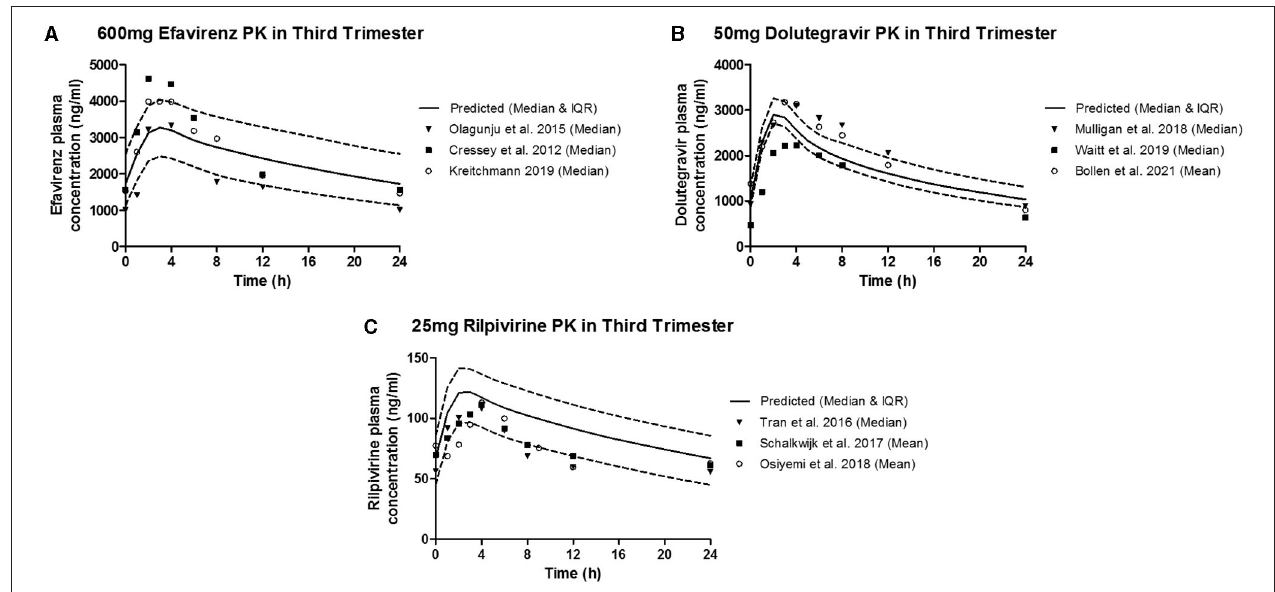
FIGURE 3 | Median (IQR) Predicted vs. Observed plasma concentration-time profile following standard dose of (A) 600mg efavirenz, (B) 50mg dolutegravir, and (C) 25mg rilpivirine in third trimester.